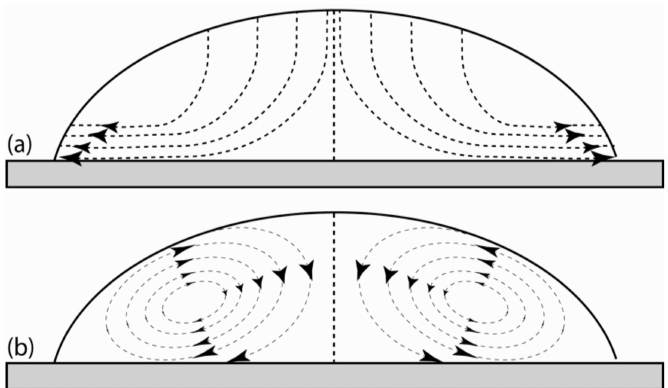
Figure 1. Schematic of ( a ) outward capillary flow during the drying process, and ( b ) Marangoni flow (circulatory fluid flow) inside a